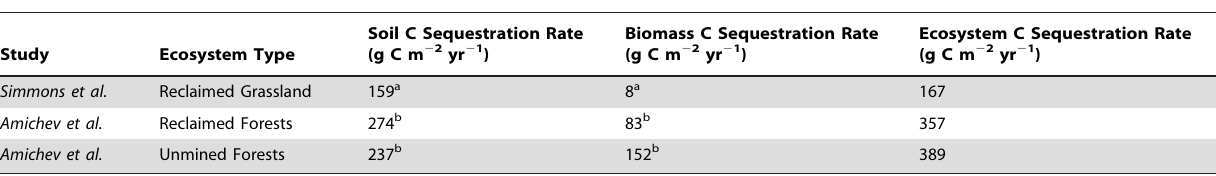
Table 2. Foregone ecosystem C sequestration per unit coal produced.